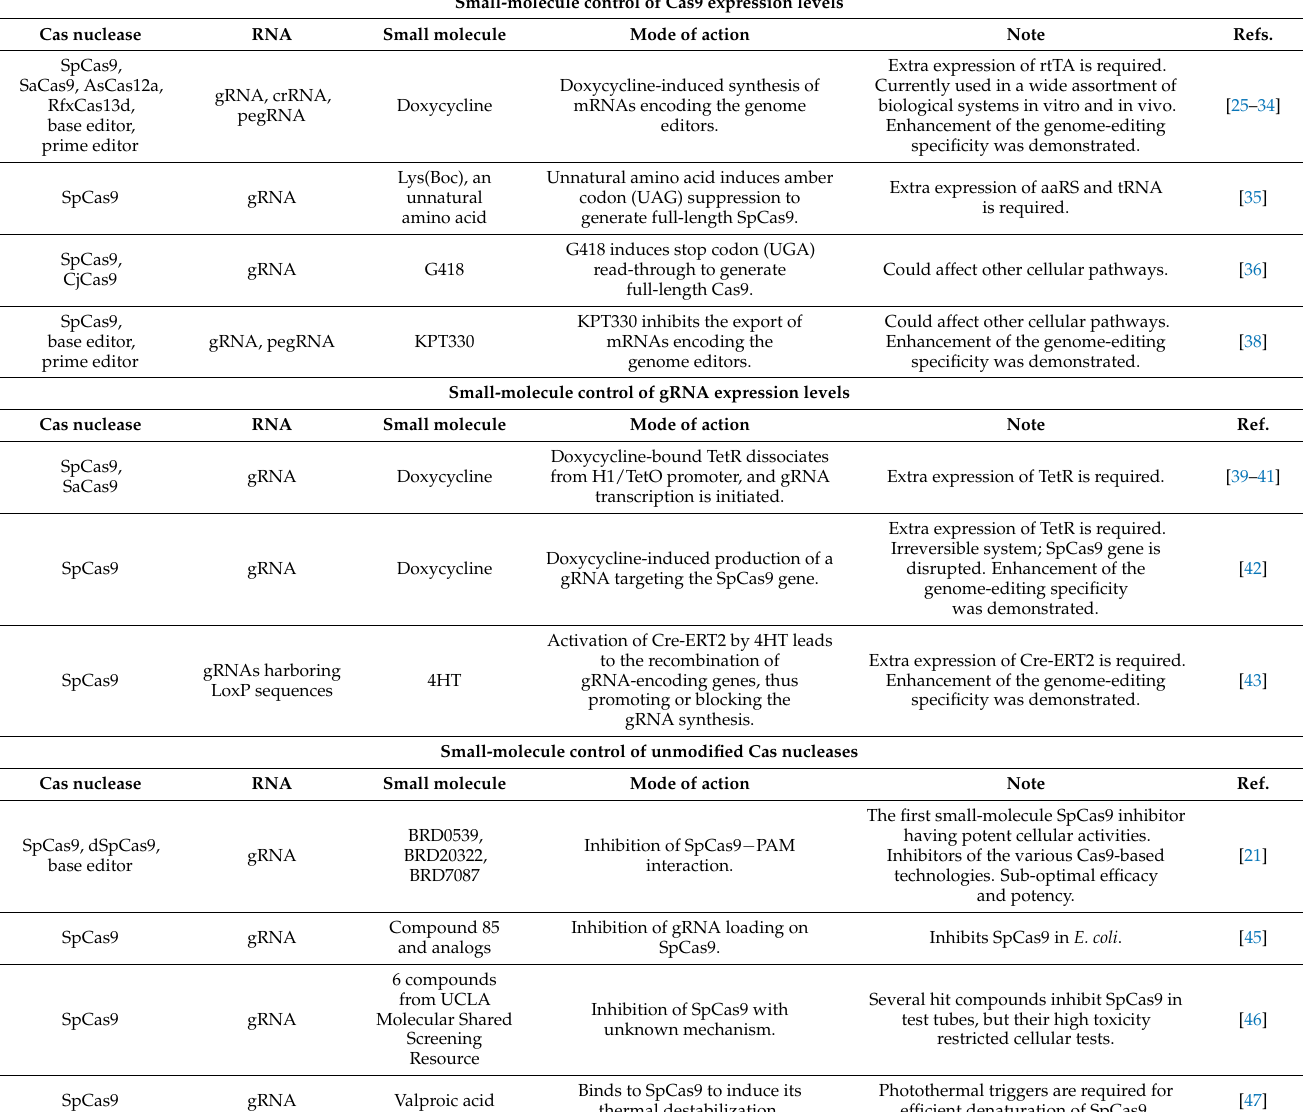
Table 1. Examples of small molecules that control the activity and duration of Cas nucleases and